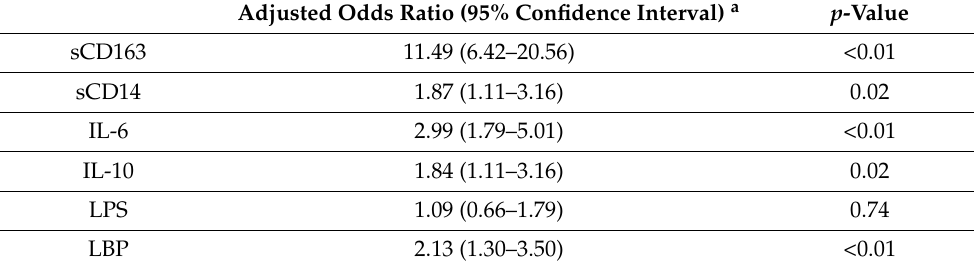
Table 4. Logistic regression for the association between marker levels in the highest quartile and advanced liver